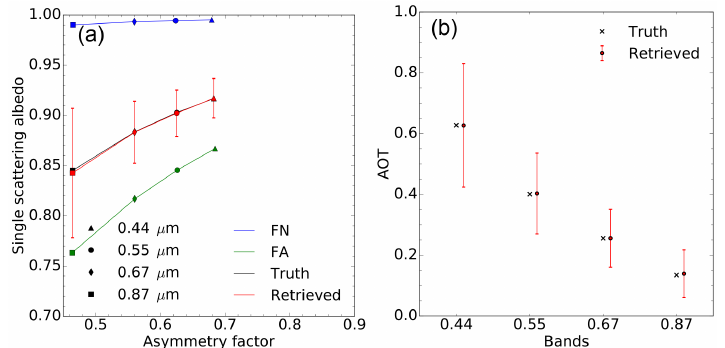
Figure 5. (a) Results of experiment F00 in the { g,ω 0 } space. The aerosol vertices used for the inversion are FN (blue) and FA (green). The forward aerosol properties are shown in black and the retrieved ones in red. Vertical and horizontal red bars indicate the uncertainty of the retrieved values. (b) Retrieved AOT (red circles). The retrieval uncertainty is shown with the vertical red lines. True values are indicated with black crosses. True and retrieved values are slightly staggered to ease the reading.